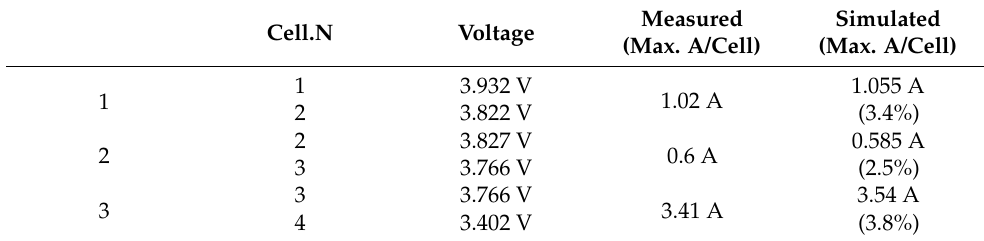
Figure 11. Comparison of the experimental and simulated results for the hot swap (3.932 V vs. 3.822 V): experimental and simulated ( a ) voltage and ( b ) current. Table 2. Components of the 1S4P lithium battery